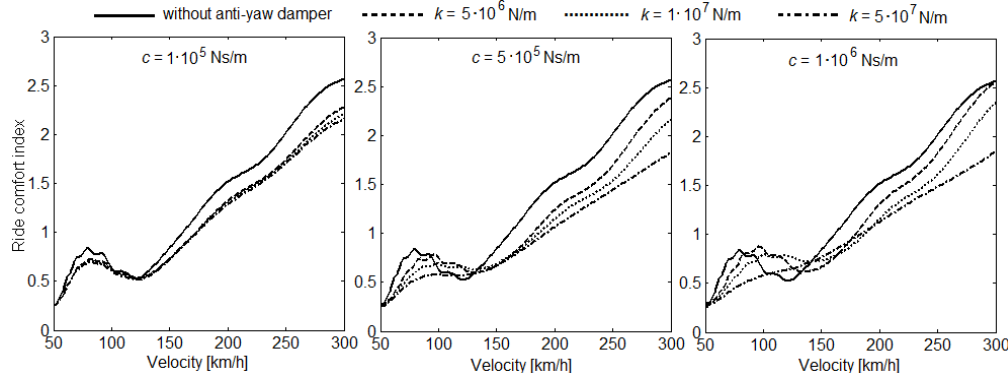
Figure 11. Influence of damping and stiffness of the anti-yaw damper upon the ride comfort index in the front bogie.